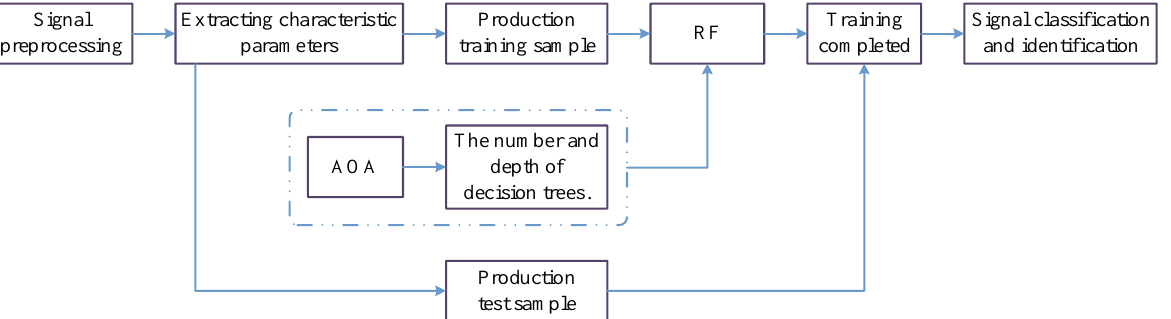
Figure 3. Overall technology roadmap for modulated signal identification.